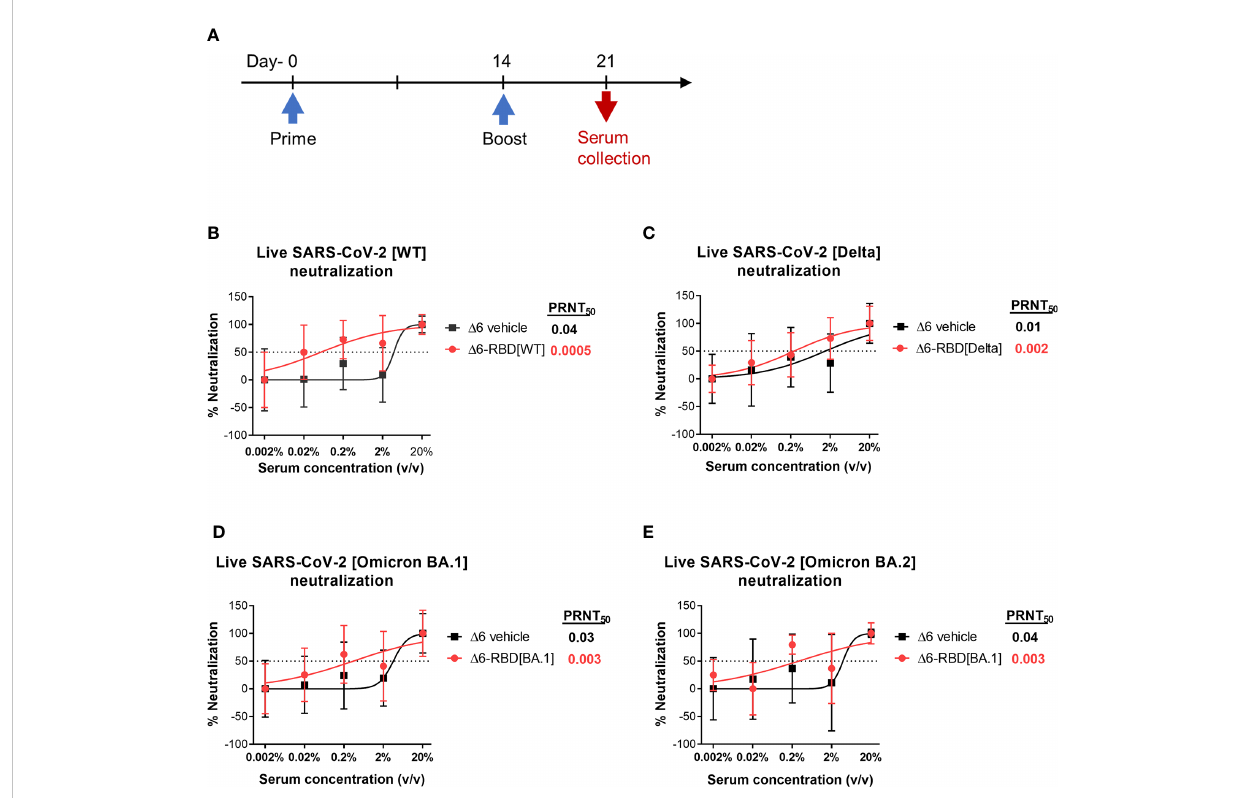
FIGURE 3 Assessment of aPA-RBD as vaccine against live SARS-CoV-2. (A) A prime-boost regimen was performed. Mice (n=6 per group) were vaccinated with D 6-RBD[WT], D 6-RBD[Delta] and D 6-RBD[Omicron BA.1], and the sera were collected at 1 week after the second immunization. (B, C) Plaque reduction neutralization test (PRNT) assay of D 6-RBD[WT] and D 6-RBD[Delta] to wild ‐ type virus (Wuhan ‐ Hu ‐ 1) and Delta variant. Fifty percent of the plaque reduction neutralizing antibody (PRNT 50 ) titers against live SARS-CoV-2 were calculated as plaque reduction rate compared to Mpg (control) in Vero E6 cells. (D, E) PRNT50 of D 6-RBD[Omicron BA.1] to Omicron BA.1 and Omicron BA.2. The dashed lines indicate the level of PRNT 50